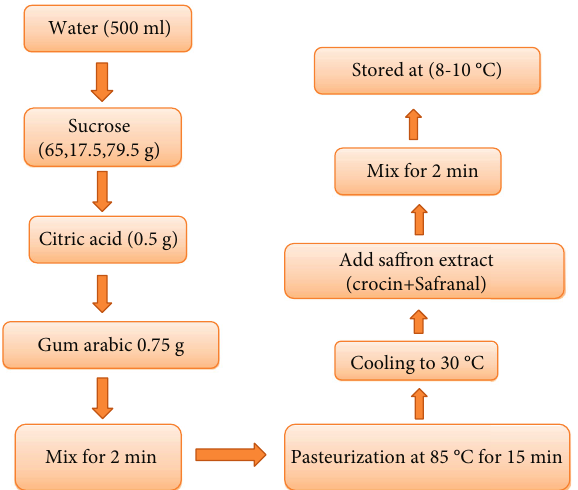
Figure 1: Flowchart of the nutraceutical beverage production with sa ff ron